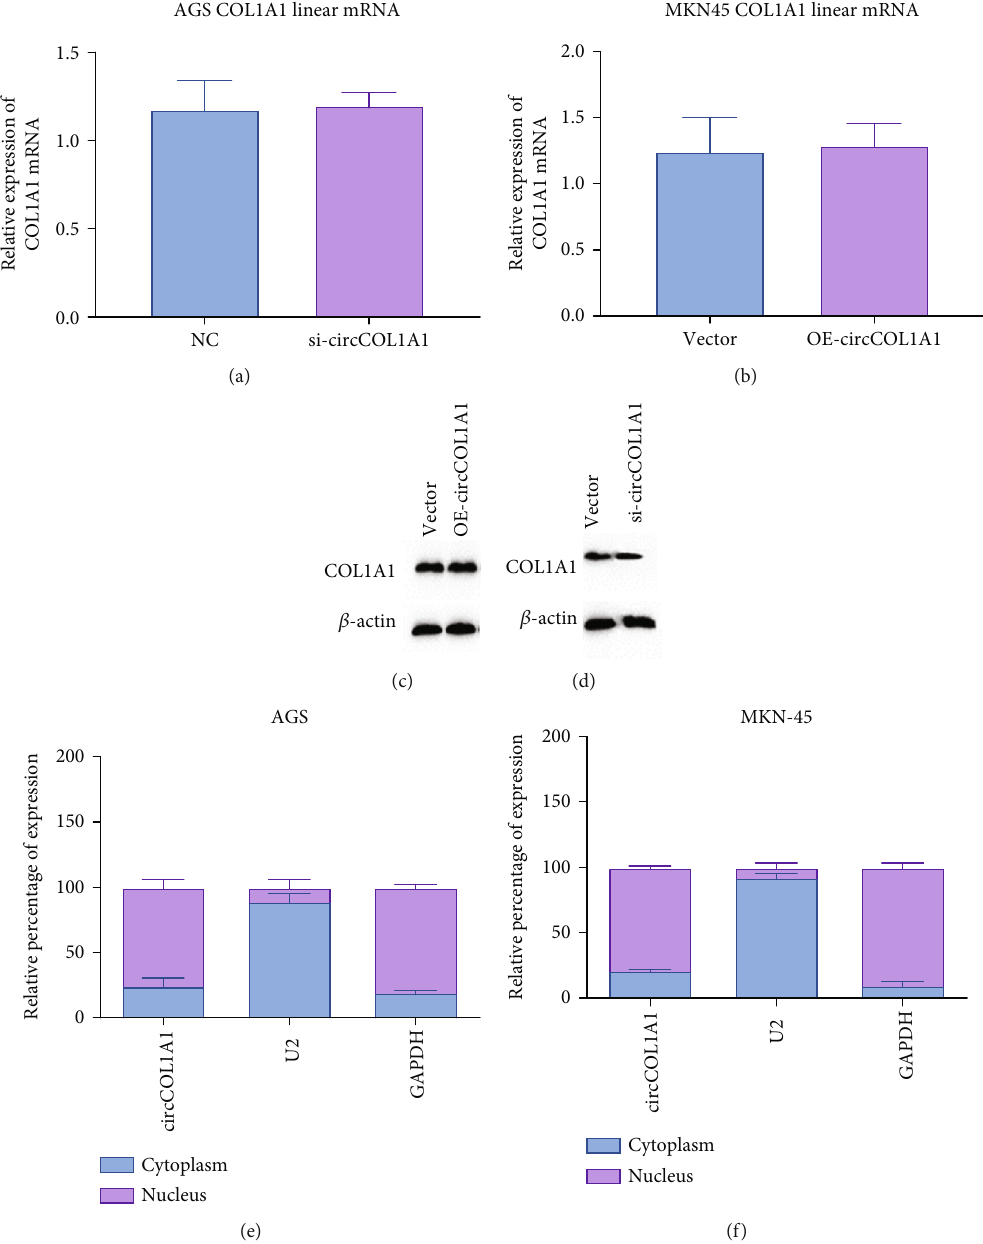
Figure 3: circCOL1A1 has no in fl uence on COL1A1 protein level and mainly locates in the cytoplasm. (a) qRT-PCR was performed to detect COL1A1 linear RNA levels in AGS. (b) qRT-PCR was performed to detect COL1A1 linear RNA level in MKN-45. (c) Western blot was performed to detect COL1A1 protein levels in AGS. (d) Western blot was performed to detect COL1A1 protein levels in MKN- 45. (e, f) Subcellular fractionation assay showed that circCOL1A1 was mainly located in the cytoplasm of AGS and MKN-45 cells. U2 and GAPDH were used as nuclear and cytoplasmic controls,